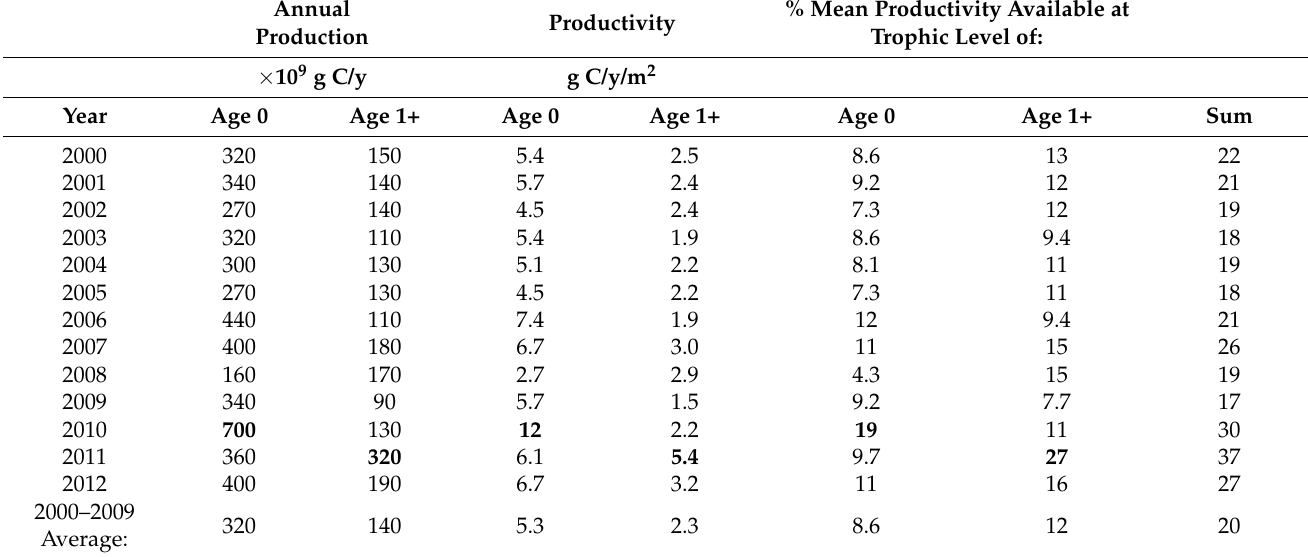
Table 3. Annual production of age-0 and age-1+ Gulf menhaden from Table 2 converted to units of grams carbon per year (g C/y) and grams carbon per year per square meter of sea surface (left-hand columns), and expressed as a proportion of total productivity available at the trophic levels of age-0 and age-1 fish, and their sum (right-hand columns). Conversion to g C/y/m 2 is based on the assumption that 75% of the Gulf menhaden productivity occurs within the blue shaded area of Figure 1, which represents 44,500 km 2 (see